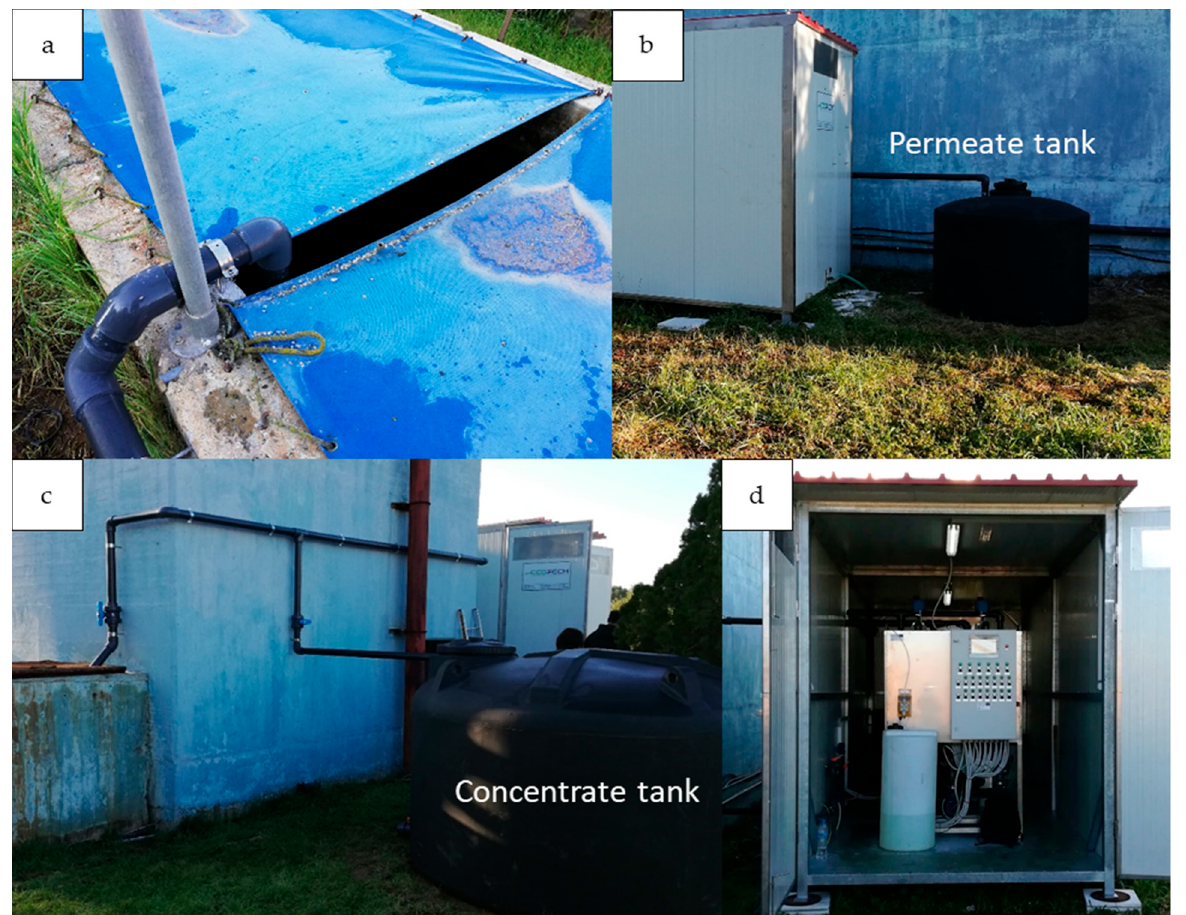
Figure 2. Pilot UF membrane unit installation at Patras’ wastewater treatment plant, ( a ) membrane feed, ( b ) permeate tank, ( c ) concentrate tank, and ( d ) membrane unit housing.